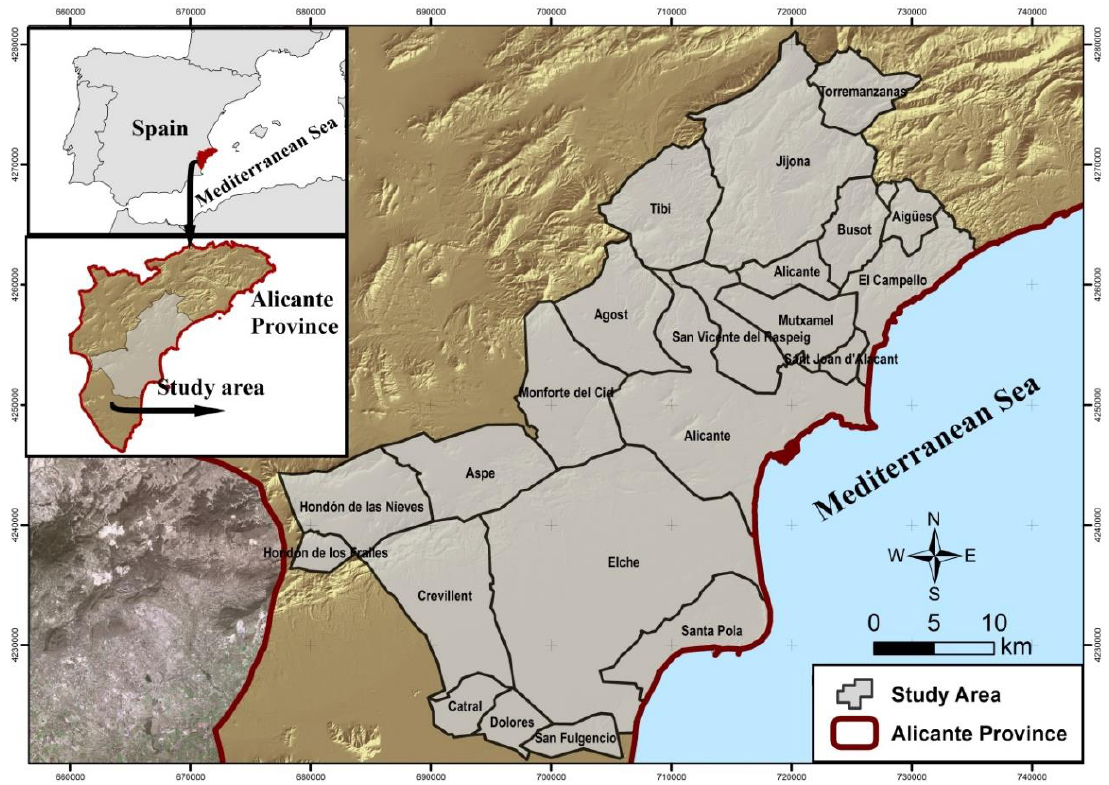
Figure 1. Study area with 21 municipalities ( Alicante province, Southeast Spain).